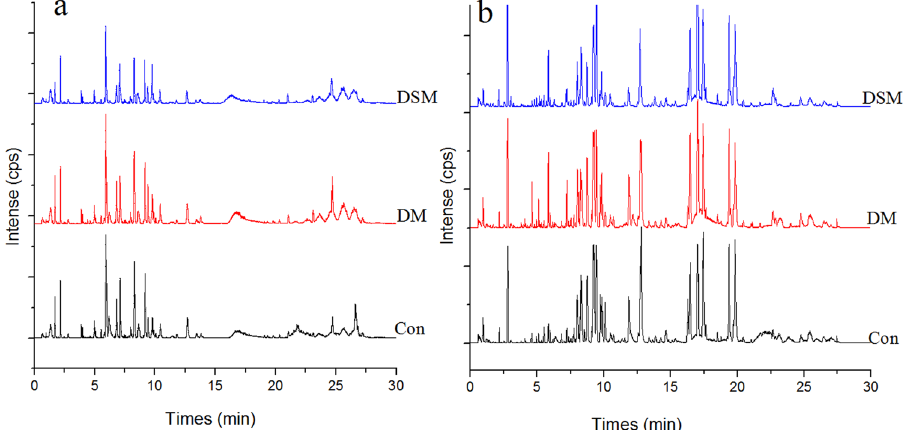
Figure 3. Representative base peak intensity chromatogram of rat serum obtained in the ESI positive ( a ) and negative ion modes ( b ) based on UPLC-QTOF/MS. Con, control group; DM, disease model group; DSM, DS model group.